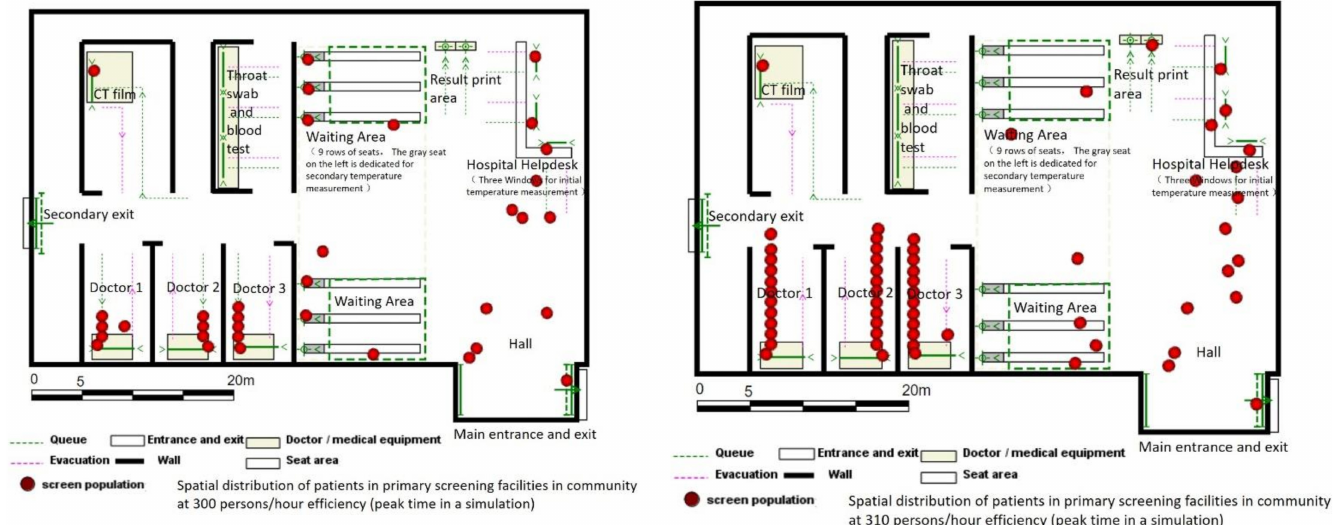
Figure 4. Schematic diagram of community virus testing facilities spatial distribution planning.